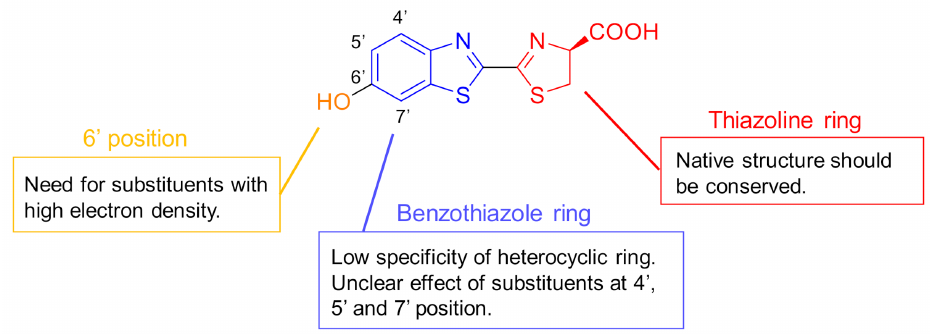
Figure 1. The substrate specificity for luciferase to emit